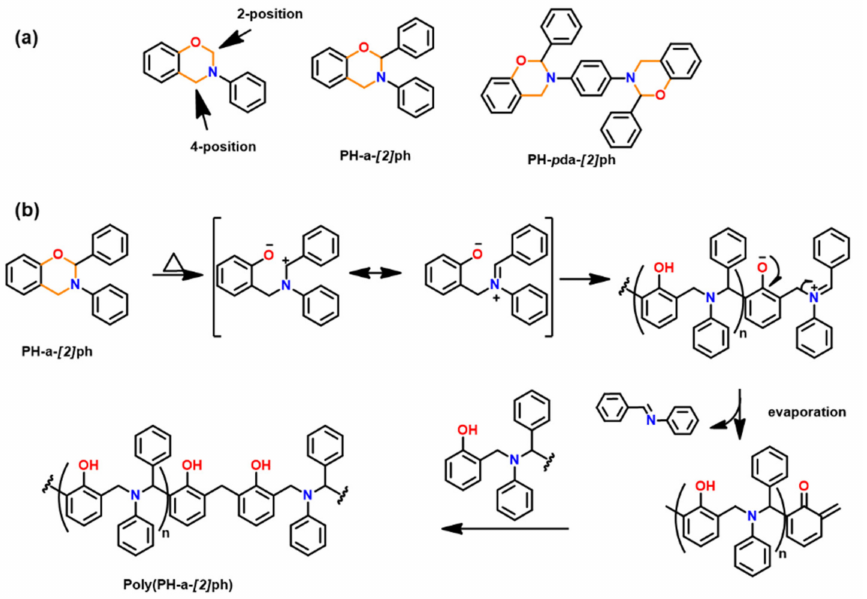
Figure 31. ( a ) Examples of oxazine ring substituted benzoxazine monomers; ( b ) proposed polymer- ization mechanism